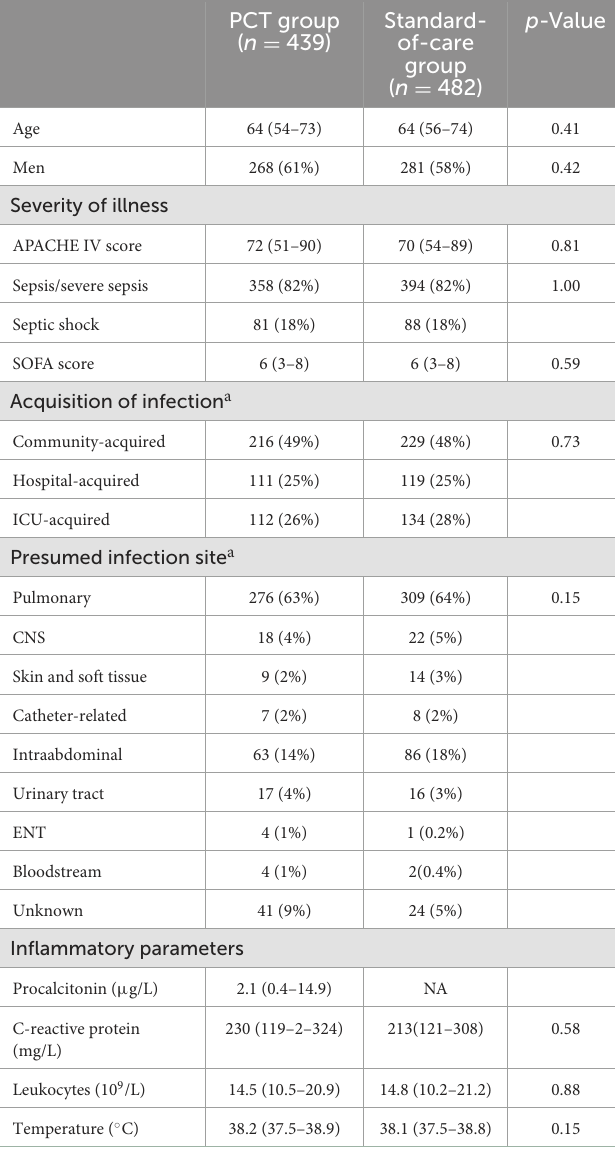
TABLE 1 Baseline characteristics.